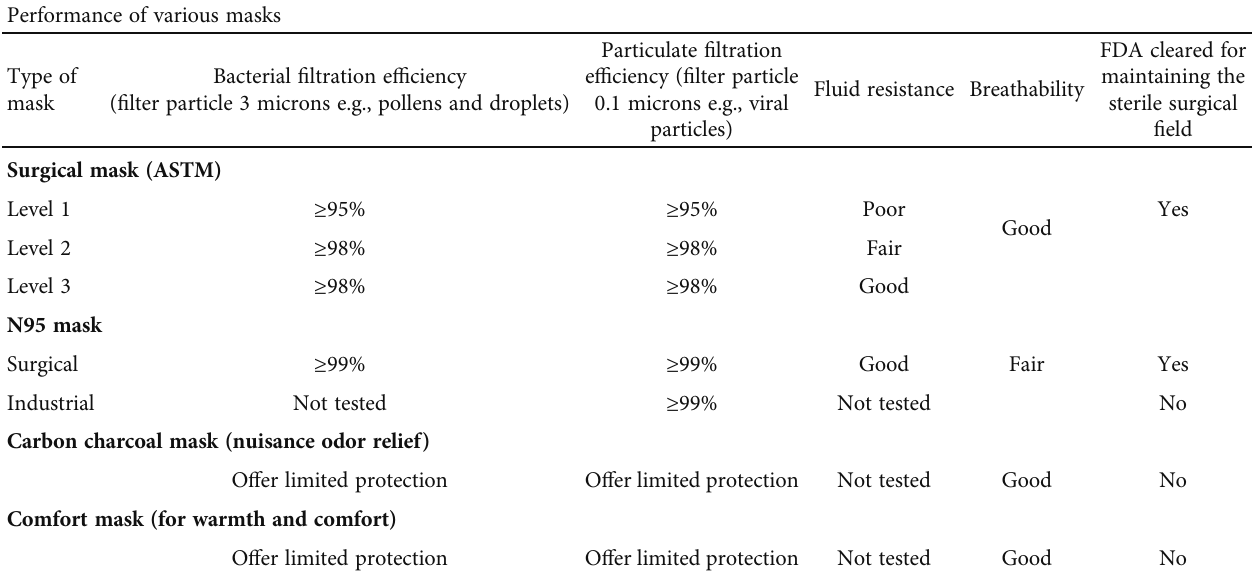
Table 1: Performance e ffi ciencies of various masks